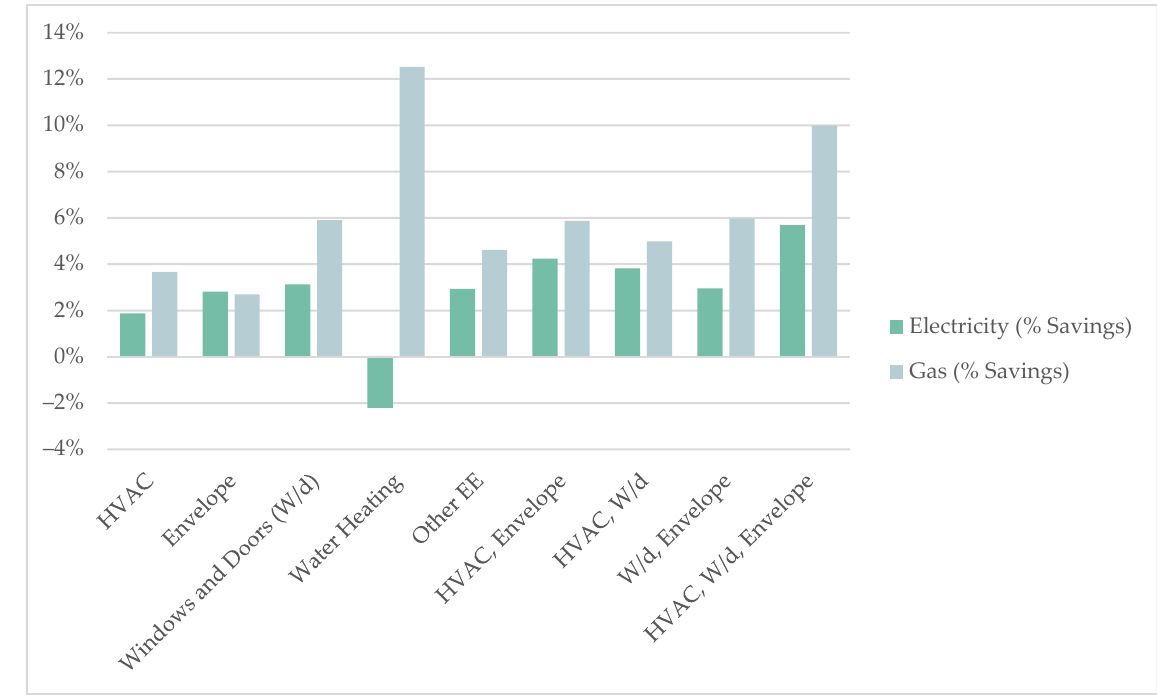
Figure 4. Energy efficiency project impacts by measure category.